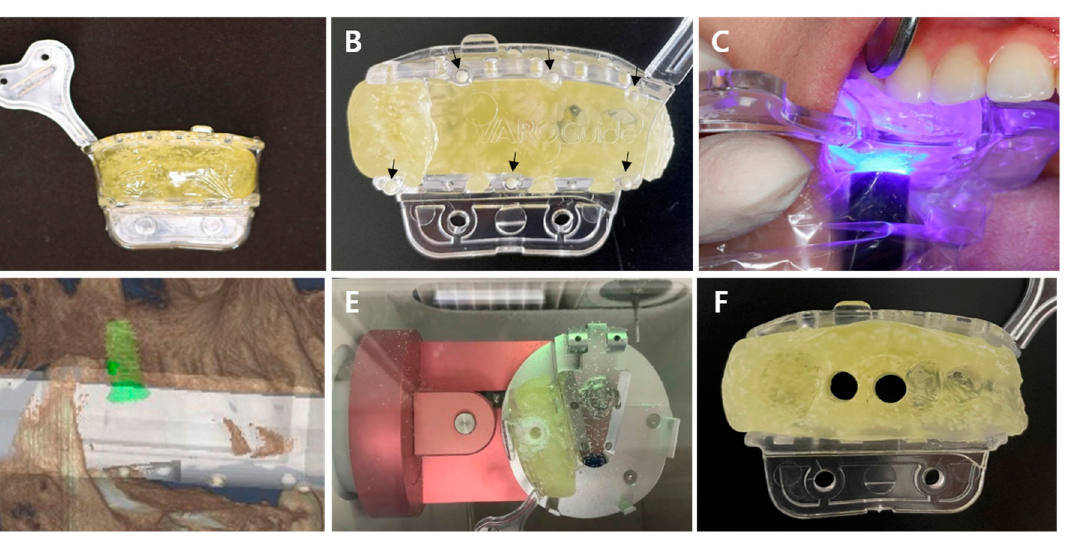
Figure 1. The fabrication process of the VARO guide. ( A ) A “pre-guide” containing composite resin was opened from its package. ( B ) The base of the pre-guide containing six radiopaque dots (arrows), which can be recognized by the milling machine. ( C ) The pre-guide was applied to the edentulous site and then light-cured. ( D ) Once the cone-beam computed tomography was taken with pre-guide in situ, virtual planning was conducted on computer software. ( E ) Using the planned data, the VARO guide was fabricated by the VARO milling machine. ( F ) The completed VARO guide having a drill sleeve.